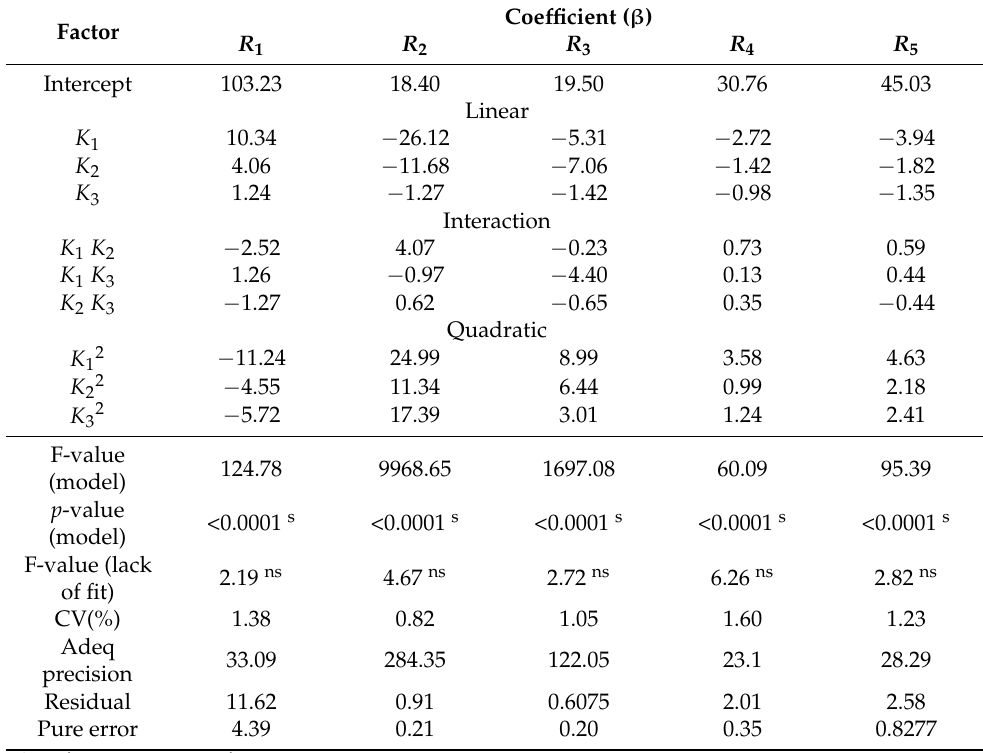
Table 4. Regression coefficients ( β ) and analysis of variance (ANOVA) of the predicted second-order polynomial modes for TPC, antioxidant, and anticancer activity.